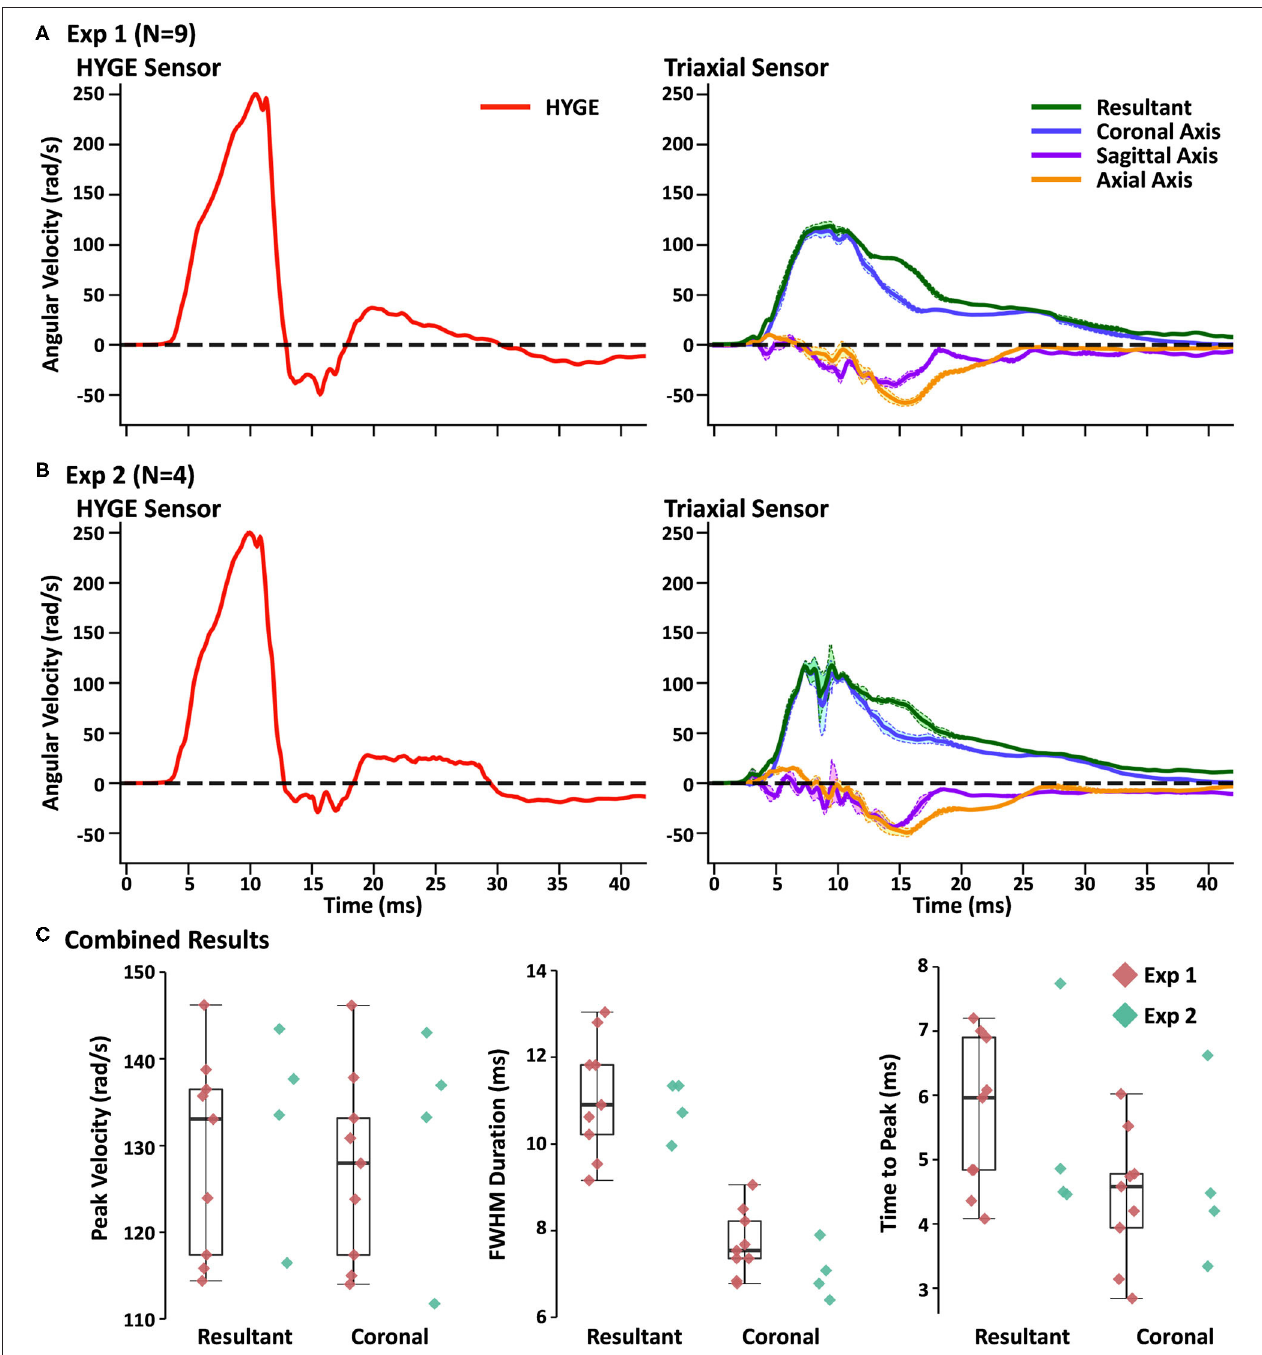
FIGURE 2 | (A) Average angular velocity traces (radians per second: rad/s) for experiment (Exp) 1 collected with the HYGE machine sensor (left column; red trace) and triaxial skull sensor (right column; resultant: green trace; coronal axis: blue trace; sagittal axis: purple trace; axial axis: orange trace) in the initial testing cohort ( N = 9). Off-color shaded bands represent the standard error of the mean for each trace. All angular velocity traces are windowed to include 4ms of data prior to the identified rise time. (B) Plotted data for replication cohort (Exp 2; N = 4) machine and skull sensors using an identical scheme. (C) Box and scatter plots (Exp 1; red diamonds) or scatter plots (Exp 2; teal diamonds) for peak velocity, full width at half-maximum of the impulse based on peak, and time to peak. Data are plotted separately for the resultant and the coronal axis of the skull sensor data. multiplanar motion is present in both axes, corresponding with exhibiting a longer impulse duration, most likely indicative of the absolute magnitude of rotational velocity in the sagittal multiplanar movement. This can be further confirmed through (54.7 ± 14.5 rad/s) and axial (62.6 ± 11.2 rad/s) an examination of the right column of Figure 2A . Consistent